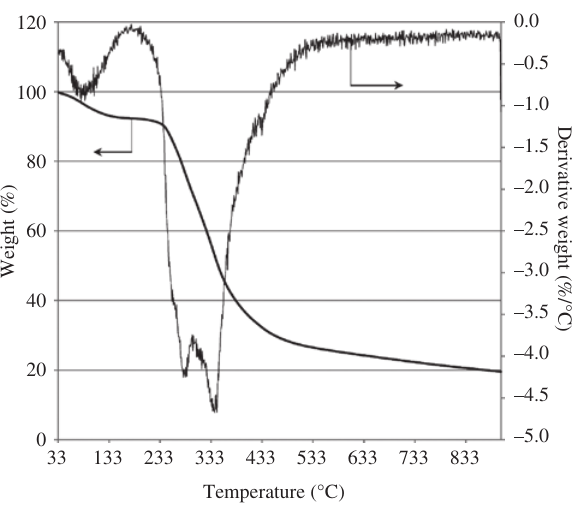
Figure 1: Thermogravimetric curve of human hair.